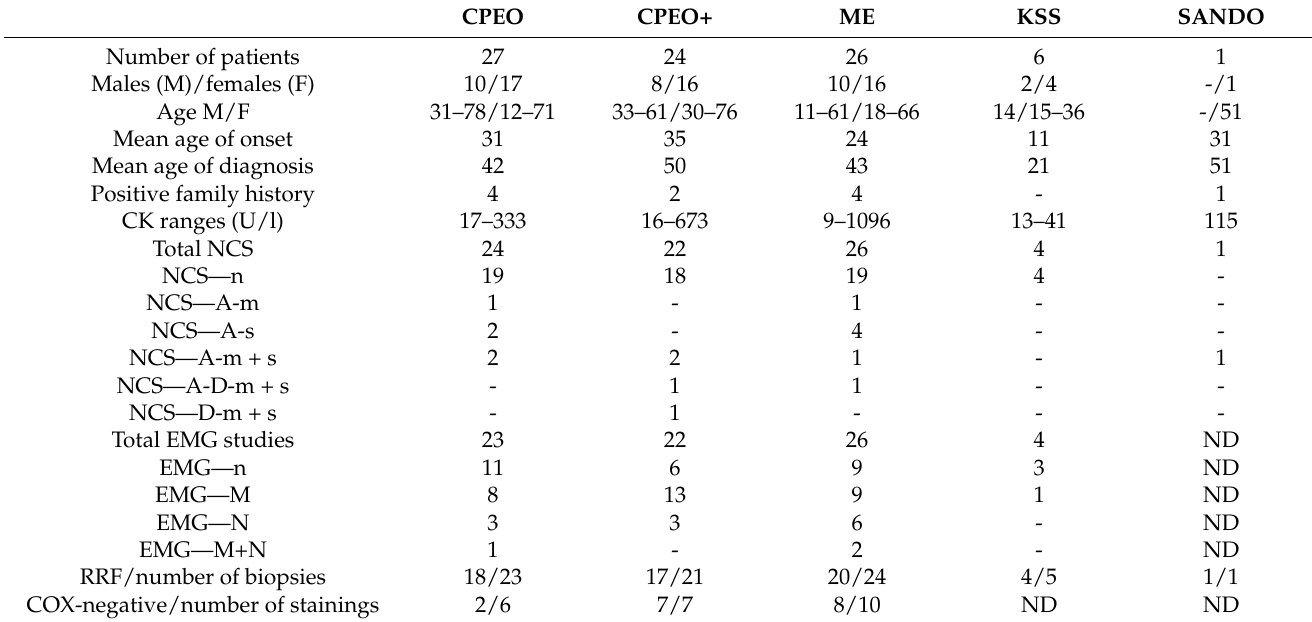
Table 1. Characteristics of patients with progressive external ophthalmoplegia.